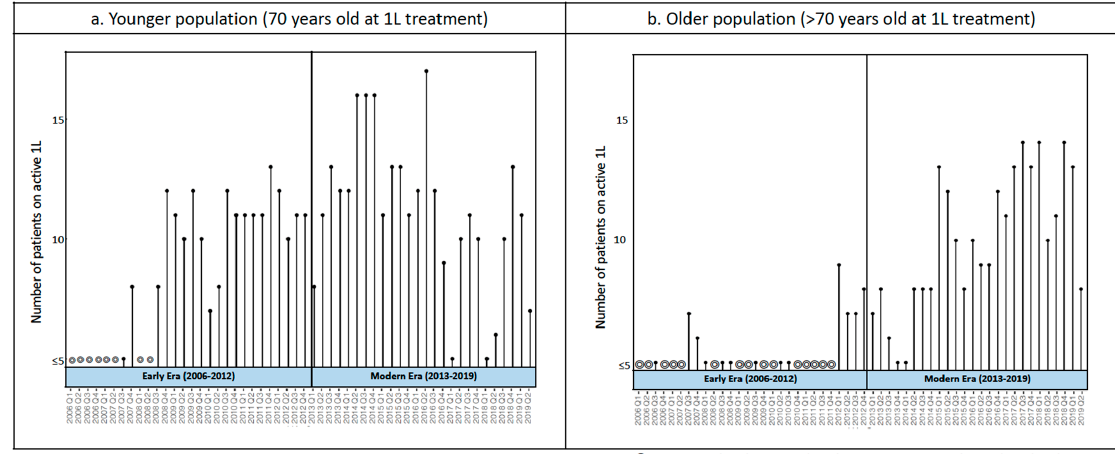
Figure A1. Number of patients receiving active first-line treatments for Waldenström macroglobulinemia per quarter-year, 2006 to 2019: ( a ) number of patients on active first-line treatments in younger population (70 years of age or younger at initiation of 1 L therapy); ( b ) number of patients on active first-line treatments in older population (older than 70 years of age at initiation of 1 L therapy).